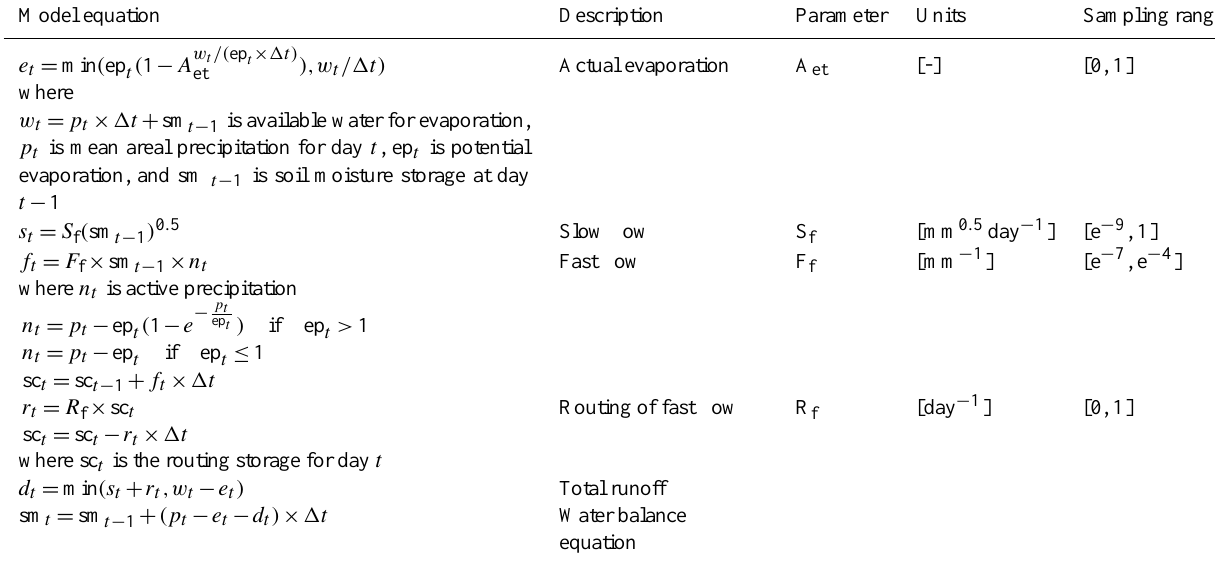
Table 1. List of equations, parameters and their sampling ranges for the version of WASMOD used in this study. Model